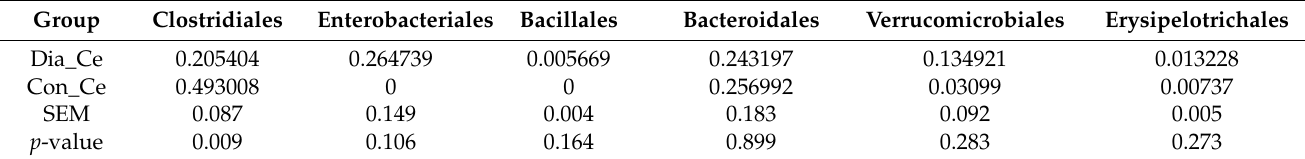
Table 2. Cecum microflora taxonomic composition at order level.